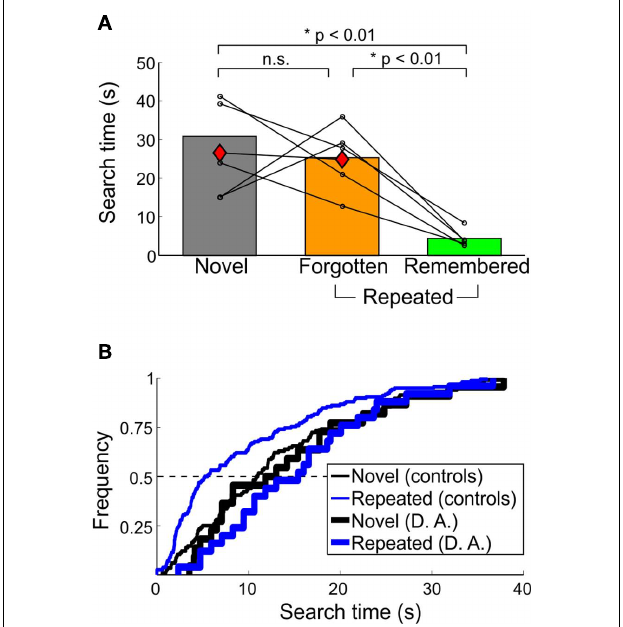
Experiment 3. (A) Median search times and (B) cumulative frequency of D. A. compared to controls. For (A) , conventions as in Figure 3B . D. A.’s performance is indicated by the red diamonds; all repeated trials